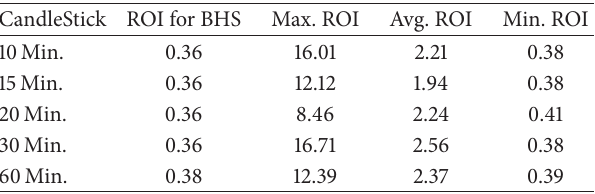
Table6:ROIcomparisonbetweenBHSandtheimprovedPRMiner.